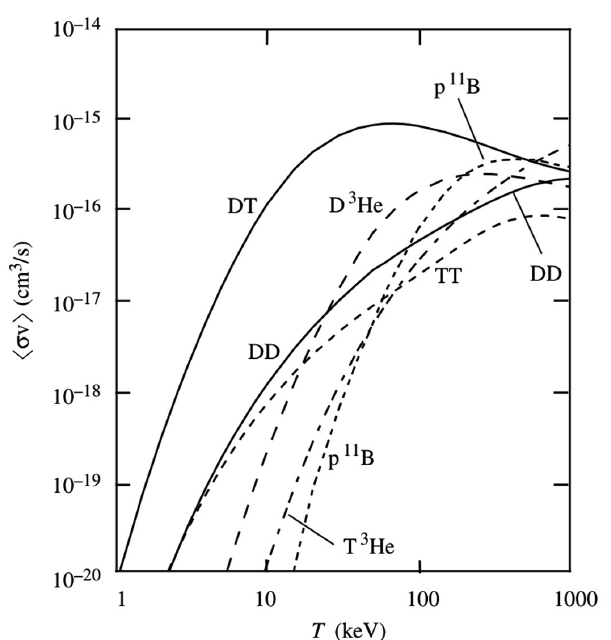
Fig. 4. – Reactivity averaged over a Maxwell-Boltzmann distribution as a function of temperature for the fusion reactions of fig. 3.